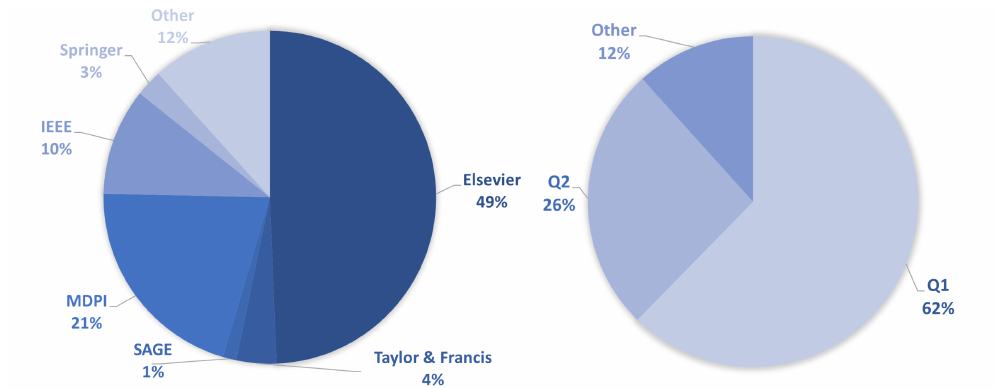
Figure 2. Overview of gathered literature aggregated by the publication year.